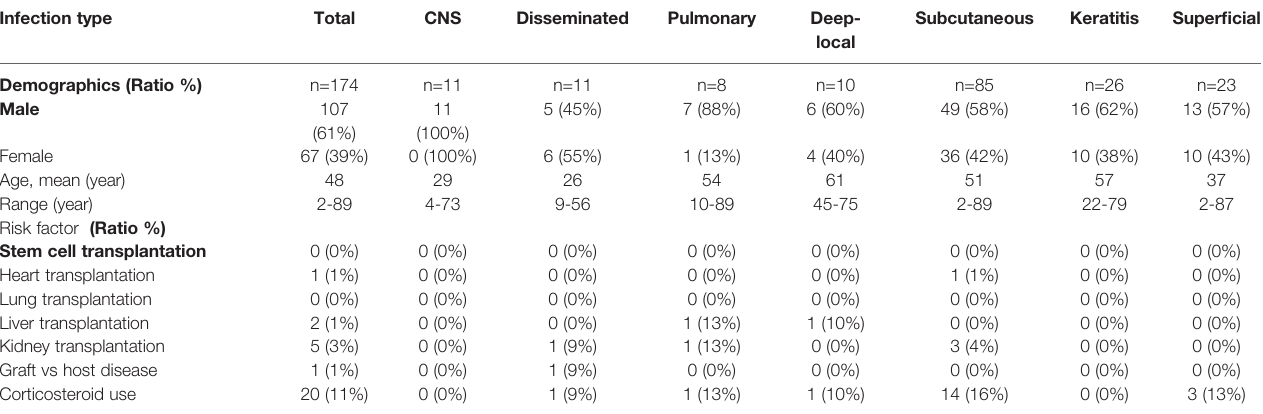
TABLE 1 | Demographics and risk factors of phaeohyphomycosis in